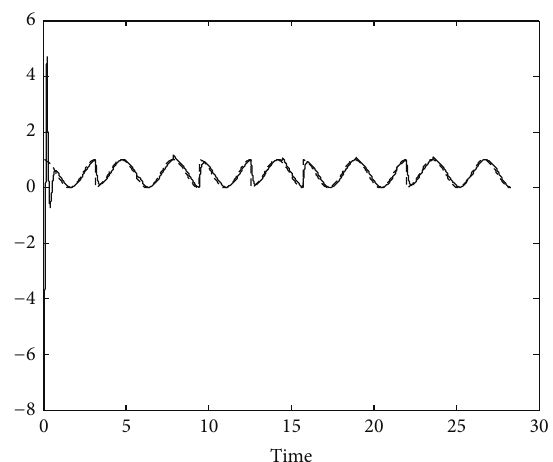
Figure 8: Actual carrier signal 𝑎 (dashed line) and decrypted carrier signal ̂𝑎 (solid line) when 𝑟 = 10 .